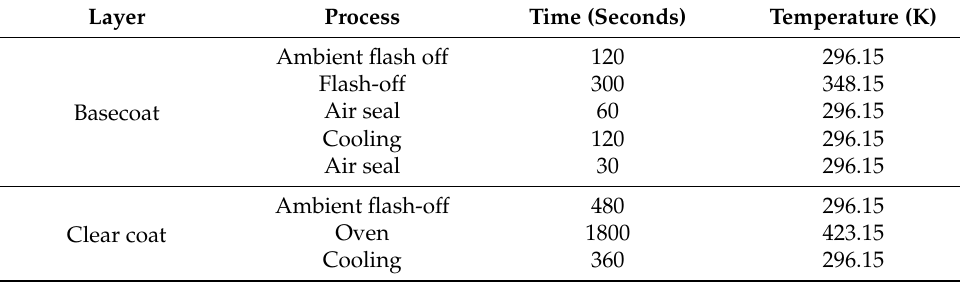
Table 3. Operating conditions for drying and curing processes, adapted from